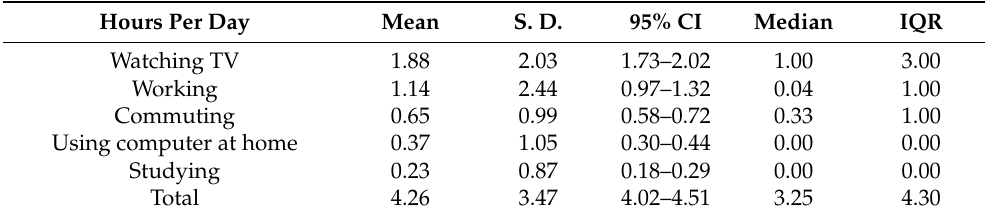
Table 2. Description of sedentary behavior of adults attending basic health units. S ã o Jos é dos Pinhais, Paran á , Southern Brazil, 2019 (n = 779).